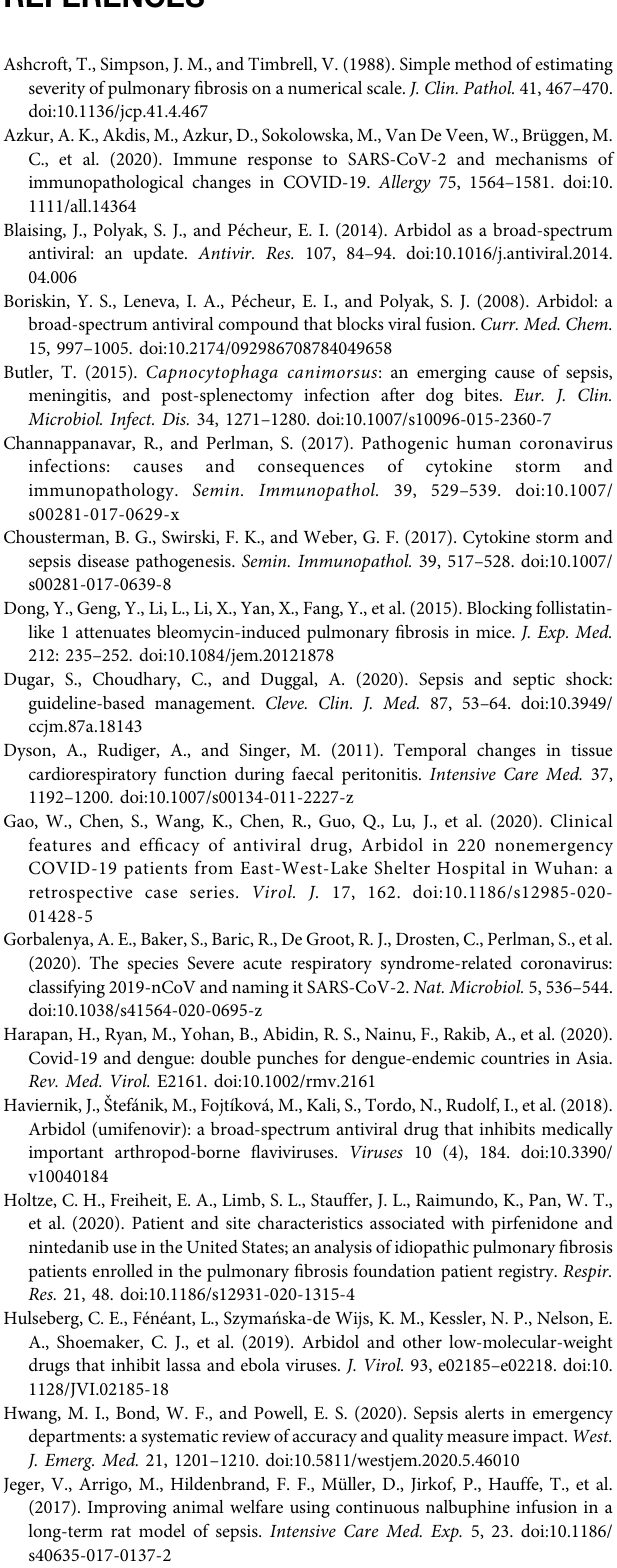
receptor (EGFR) signaling in SARS coronavirus-induced pulmonary fi brosis. Antivir. Res. 143, 142 – 150. doi:10.1016/j.antiviral.2017.03.022